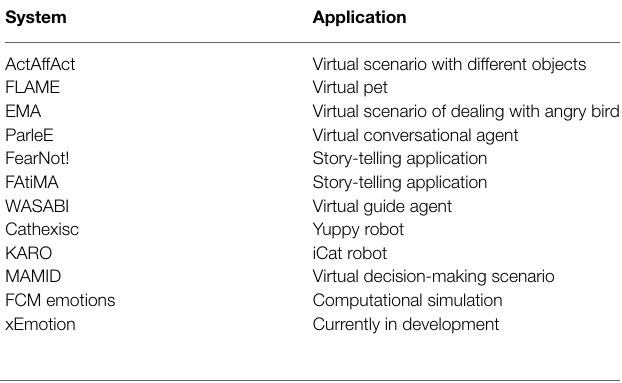
TABLE 2 | Comparison of the discussed computational systems of emotions .